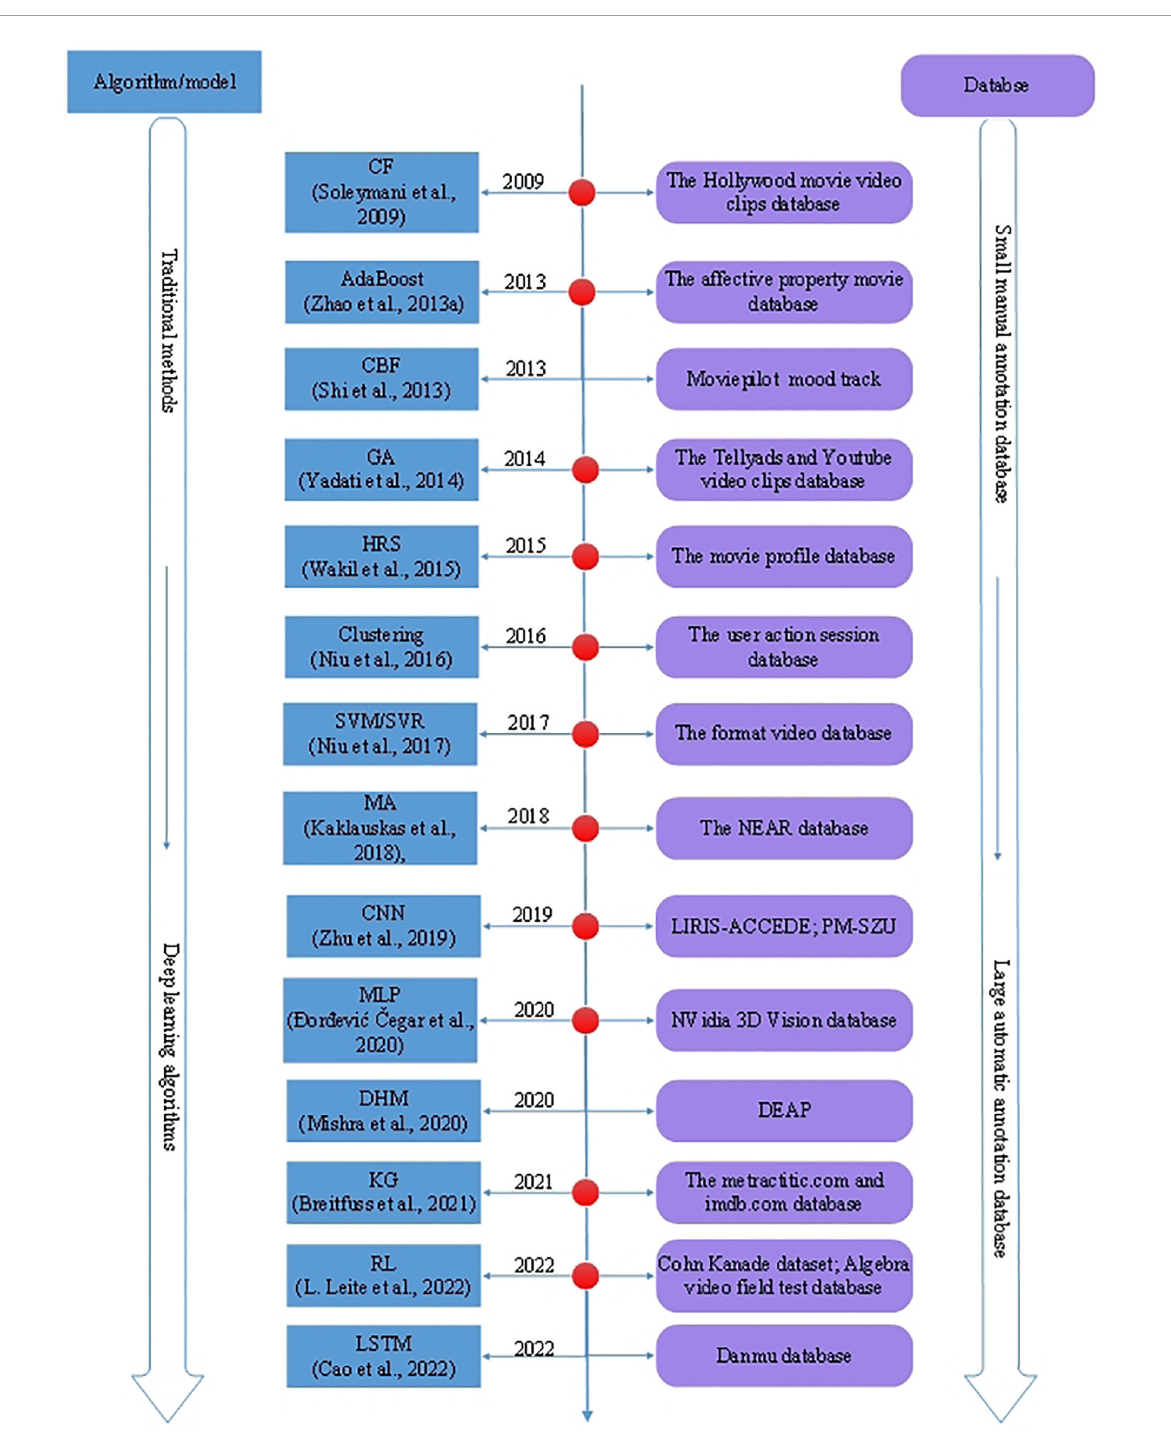
FIGURE2 The evolution of AVRS with different algorithms and databases.